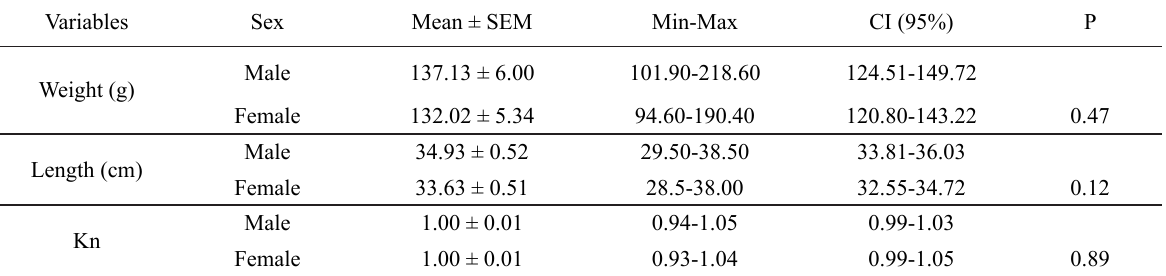
Means, standard error of the means (SEM), minimum (Min) and maximum (Max) values and confidence intervals